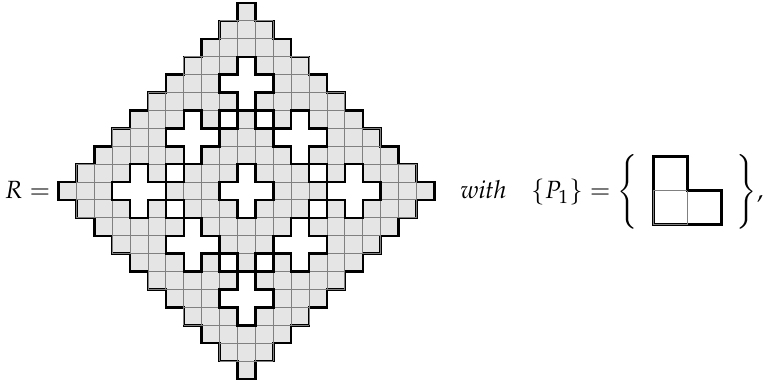
variants coloured dark-blue 1 ) = ( 72,72 ) , a − 1 1